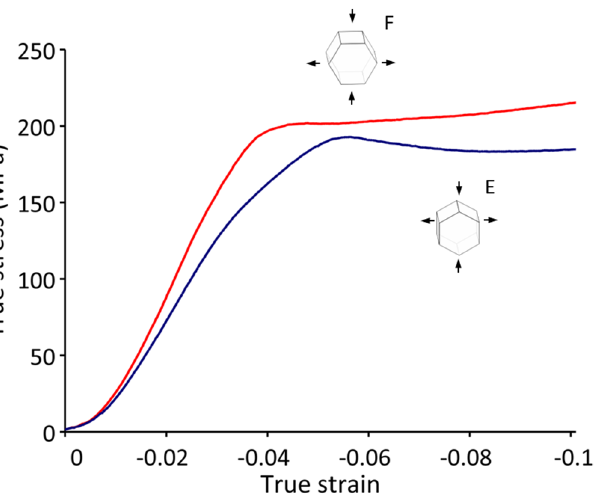
Figure 14. Flow curves of pure Mg single crystals of orientations E and F (constrained c ‐ axis) deformed by PSC at ambient temperature and a constant strain rate of 10 − 3 s − 1 . Oil was used for lubrication.